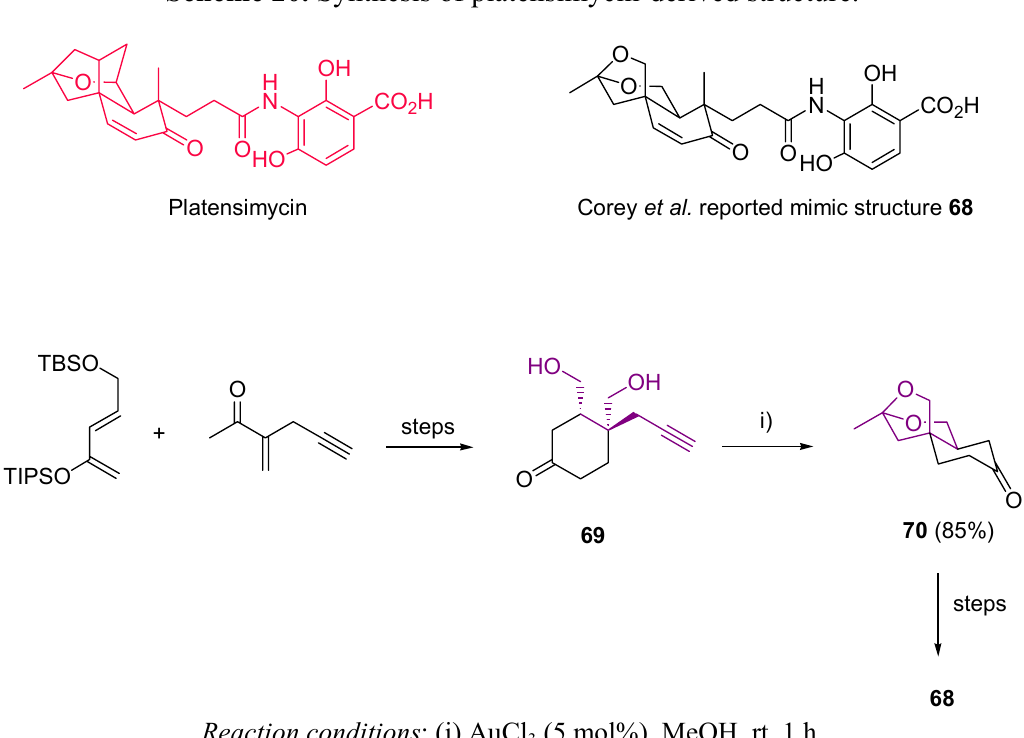
Scheme 20. Synthesis of platensimycin-derived